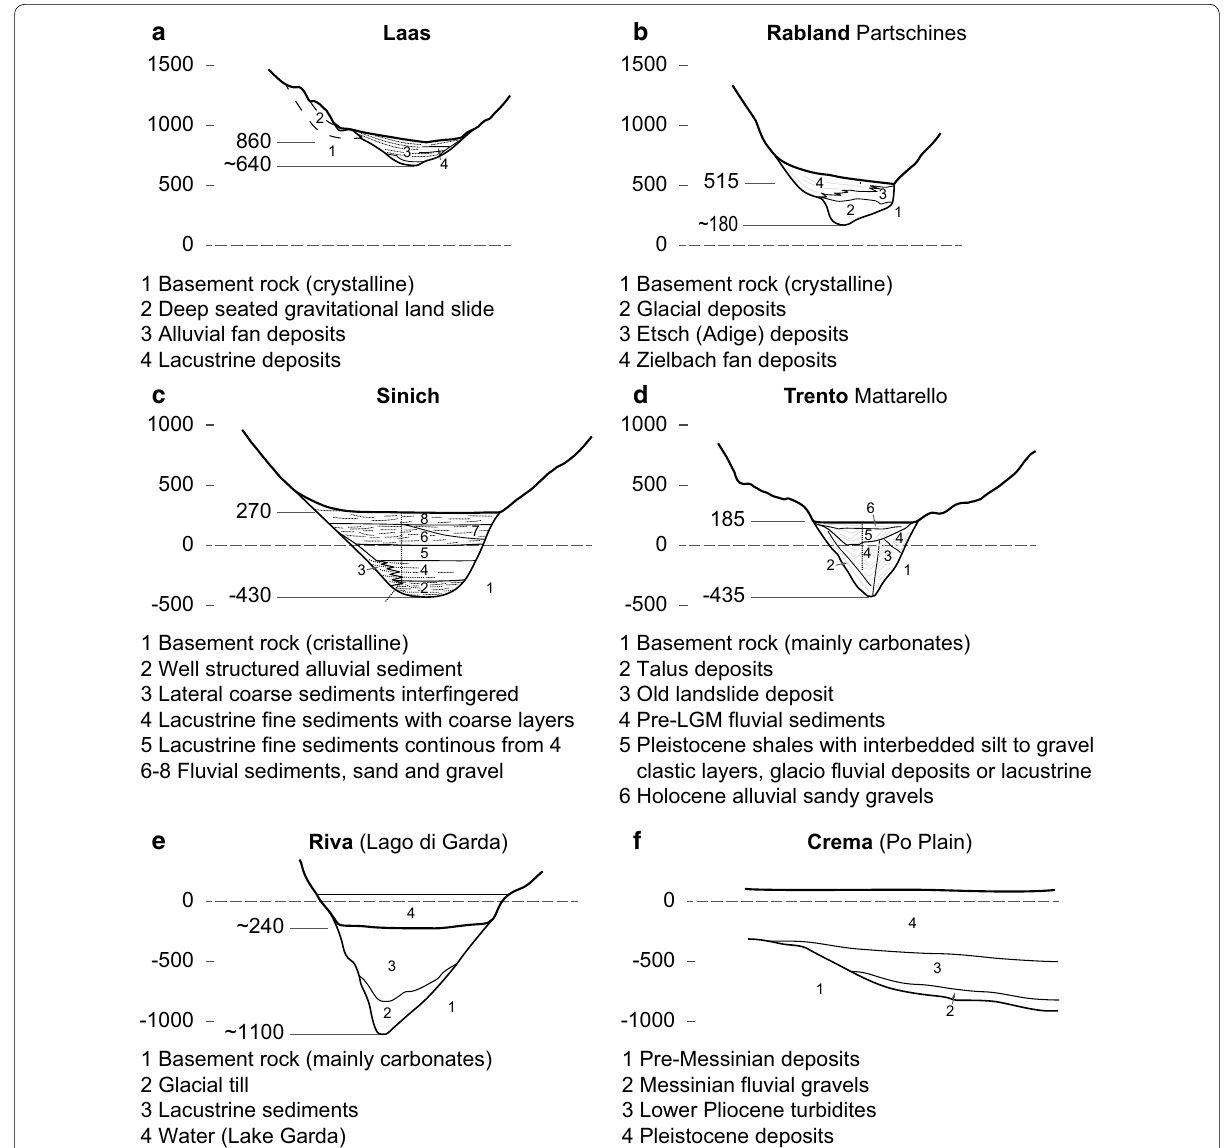
Fig. 2 Cross sections in the Adige Valley, the Lago di Garda and Po Plain showing the valley fill and the depth of the sediment bedrock unconformity (locations see Fig. 1). All profiles have a twofold vertical exaggeration, the drilling location is marked as a dotted line. a Laas section in the Vinschgau, seismic interpretation (modified after Brardinoni et al. 2018). b Rabland Partschines section 10 km upstream from Sinich. Seismic interpretation (modified after Savi et al. 2014). c Sinich section, the profile is based on seismic data and a drill hole and shows the sediment infill on the erosional unconformity that is interpreted Messinian in age (modified after Bargossi et al. 2010). Note that it is unknown if the valley bottom is U or V shaped, the original seismic line was not perpendicular to the valley. d Trento section was drilled to the pre LGM sediments but not into the basement rock (modified after Avanzini et al. 2010). e Riva (Lago di Garda), the section is in the not in today’s Adige valley (Castellarin et al. 2005). f Crema (Po Plain), this section represents the incision, presumably Messinian, of the Serio or Adige river in the Po Plain (modified after Amadori et al. 2018). Note that the crema profile is in the subsiding Po Plain, the restored incision depth here is on the order of 750